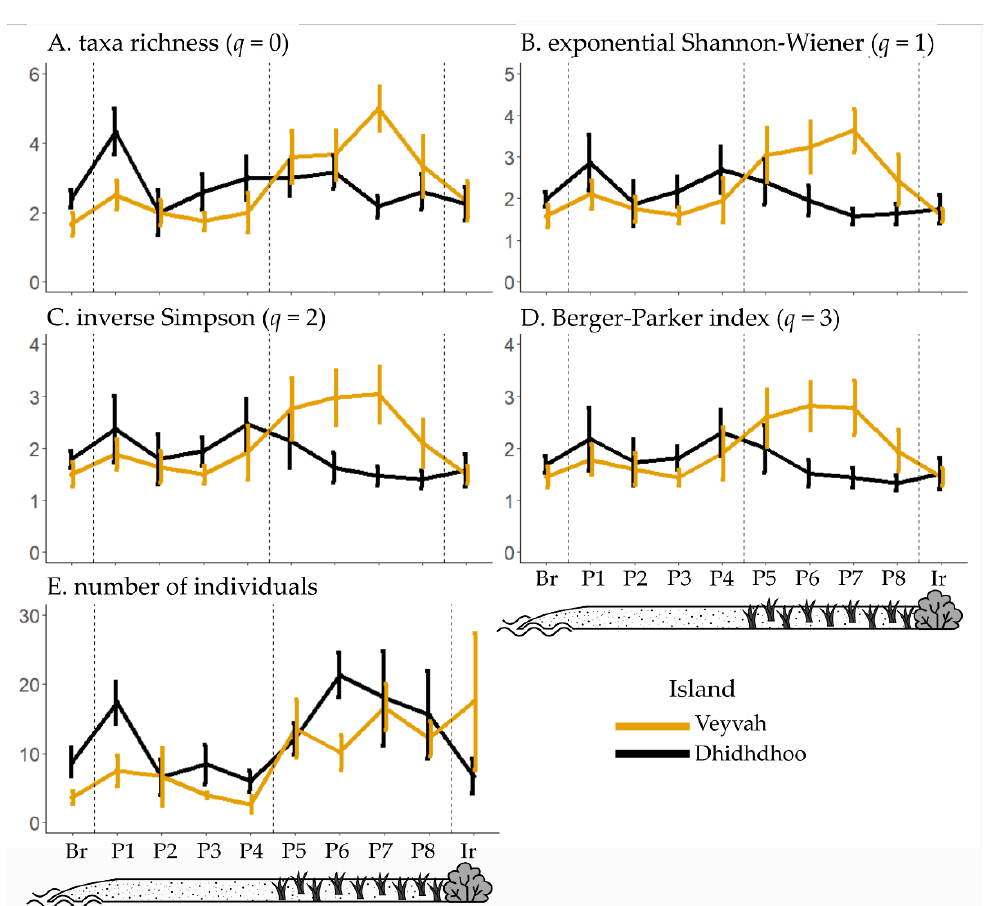
Figure 2. Change in the biodiversity parameters along the beach – inland transition zone. For each plot along the beach – inland transition zone (Br: Beach reference plot; P1 – P8: plot 1 to plot 8, with the first pioneering plants of the supralittoral vegetation starting between plot 4 and plot 5; Ir: Inland reference plot), the mean ± standard error of the four biodiversity parameters (based on Hill number q = 0, q = 1, q = 2, and q = 3) and of the total number of individuals are presented ( N = 6 per island). The two colors indicate the two different islands (black: Dhidhdhoo, orange: Veyvah). ( A ) Number of taxa per plot, ( B ) Exponential Shannon–Wiener H’ , puts species richness in proportion to their abundance. ( C ) Inverse Simpson, gives abundant species more weight and discounts for rarer ones. ( D ) Berger–Parker index, weighs also for more abundant species. ( E ) Total number of individuals per plot. None of the calculated diversity indices differed significantly between the two islands (Kruskal–Wallis: p > 0.05) or between the different plots within each island ( p >